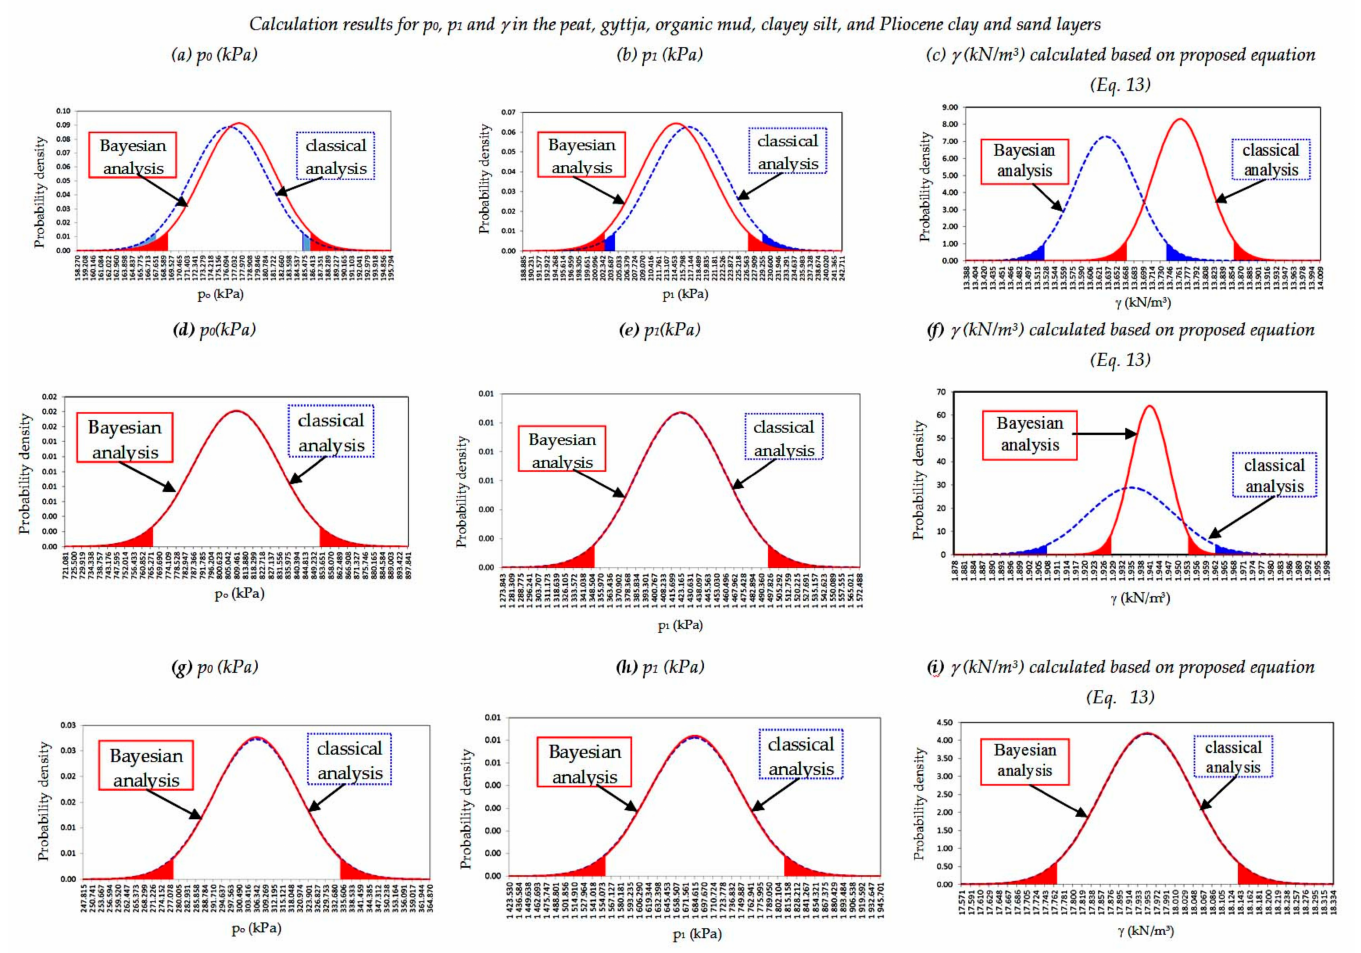
Figure 4. Dependence of calculated results for p 0 , p 1 , and γ for peat, gyttja ( a – c ), organic mud ( d – f ), clayey silt, Pliocene clay, and sand ( g – i ); layers of probability density performed in the Antoniny, Koszyce, Nielisz Stegny, and SGGW Campus